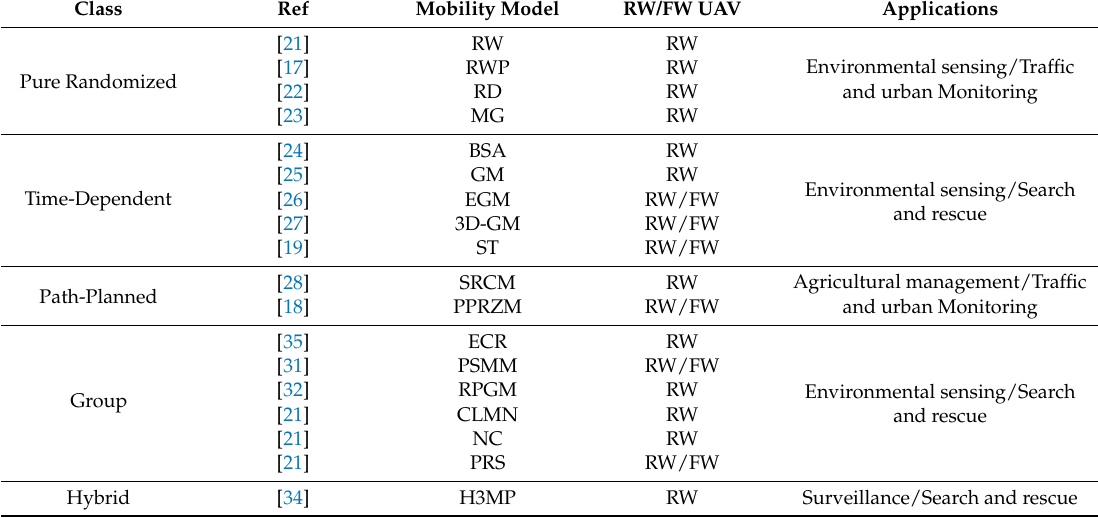
The taxonomy of mobility models, the adequate type of UAV, and examples of their